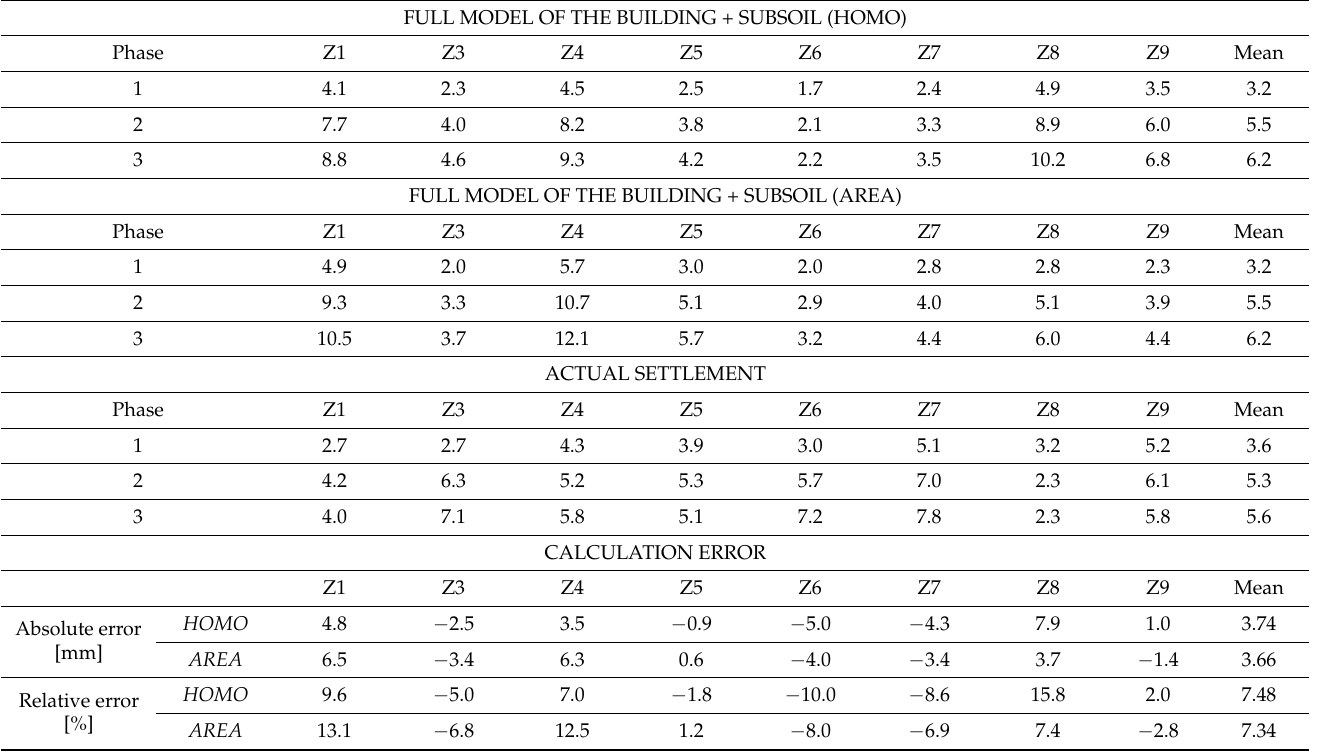
Table 7. A comparison of final settlements and settlements calculated [mm] for full models.